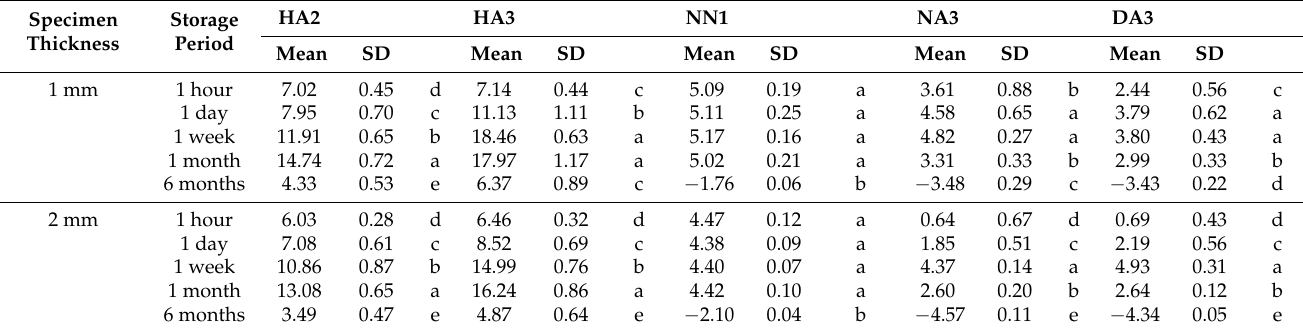
Table 3. Mean a* values of the 3D printable material specimens after different storage periods. Specimen Thickness